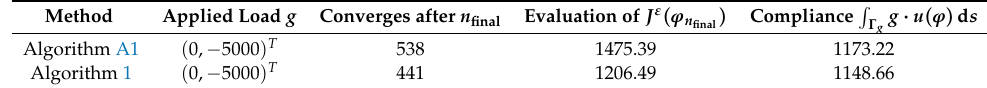
Table 1. Comparison of metrics between Algorithms A1 and 1.